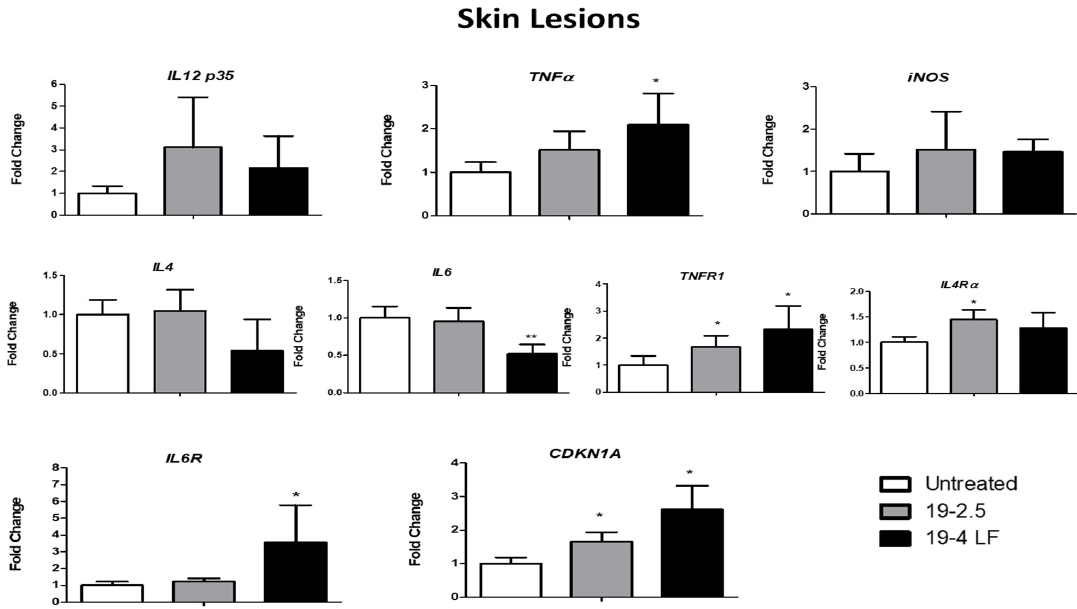
Figure 4. Gene expression levels of Th1 cytokines ( IL 12 p35 and TNF α ), iNOS gene, Th2 cytokines ( IL 4 and IL 6 ), cytokine receptors ( TNFR1 , IL4 R α and IL6 R ) and CDKN1A gene from the skin lesions of BALB/c mice treated with 19-2.5 and 19-4 LF peptides or untreated. β -actin was used as a reference gene to normalize mouse gene expression. The amount of each transcript was expressed by the formula 2 ct (actin) − ct (gene) . Bars represent the means ( ± SD) (*, p < 0.05; **, p < 0.01).